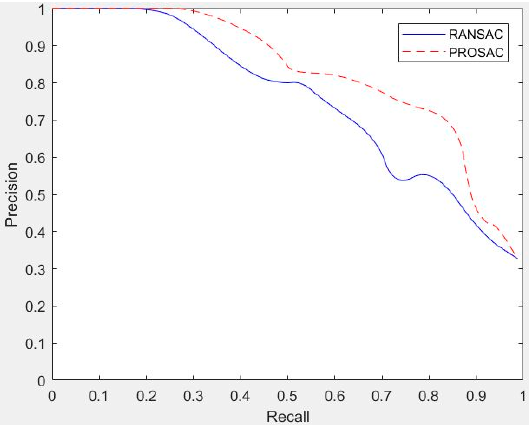
Figure 13. The precision-recall curves of RANSAC and PROSAC.